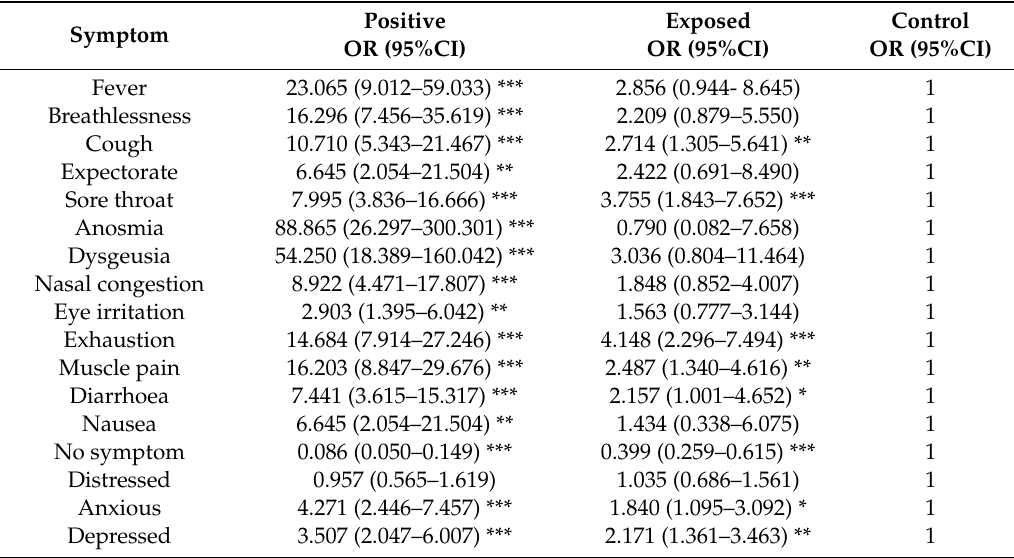
Table 4. Univariate logistic regression analysis.